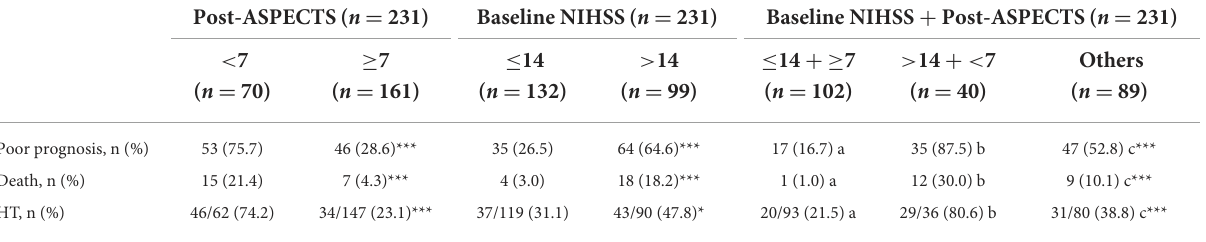
TABLE 5 Baseline NIHSS score and Post-ASPECTS predict patient prognosis. Post-ASPECTS ( n =